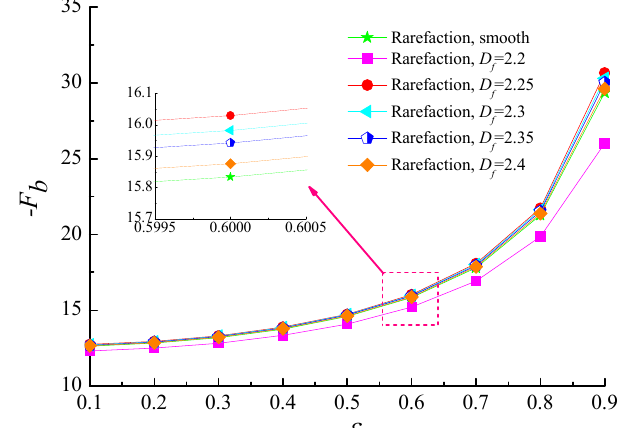
Figure 8. Static friction coefficient versus eccentricity ratio for different fractal dimensions at Λ = 20, G = 1 × 10 − 11 .